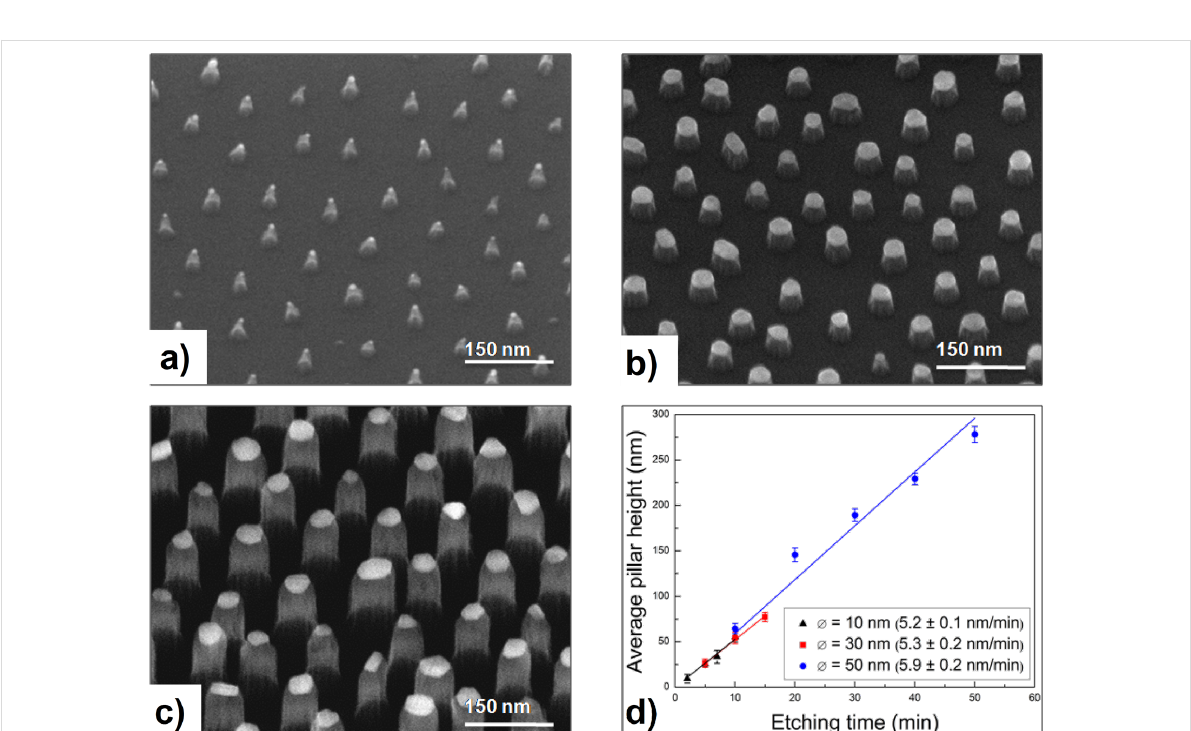
Figure 3: Nanopillar arrays etched into silica applying Au NP of different diameters as masks: (a) NP diameter = 12 nm, pillar height = 50 nm (aver- ages), (b) NP diameter = 30 nm, pillar height = 50 nm (averages), (c) NP diameter = 50 nm, pillar height = 190 nm (averages). Panel (d) Develop- ment of the average pillar height as a function of etching time for the three differently sized Au NP